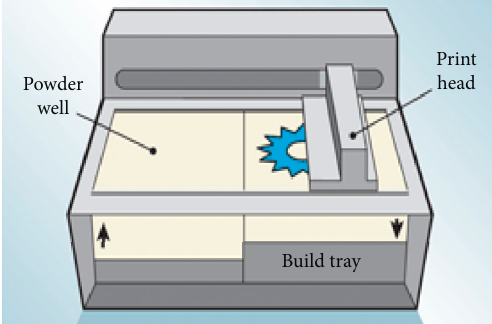
Figure 4: Three-dimensional printing